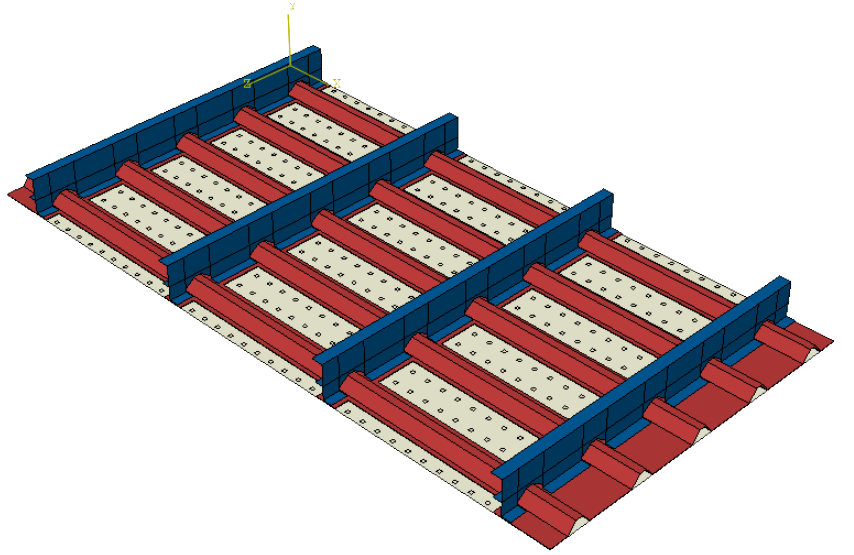
Figure 3. The 2045 × 1070 mm 2 stiffened panel with all possible sensor locations.